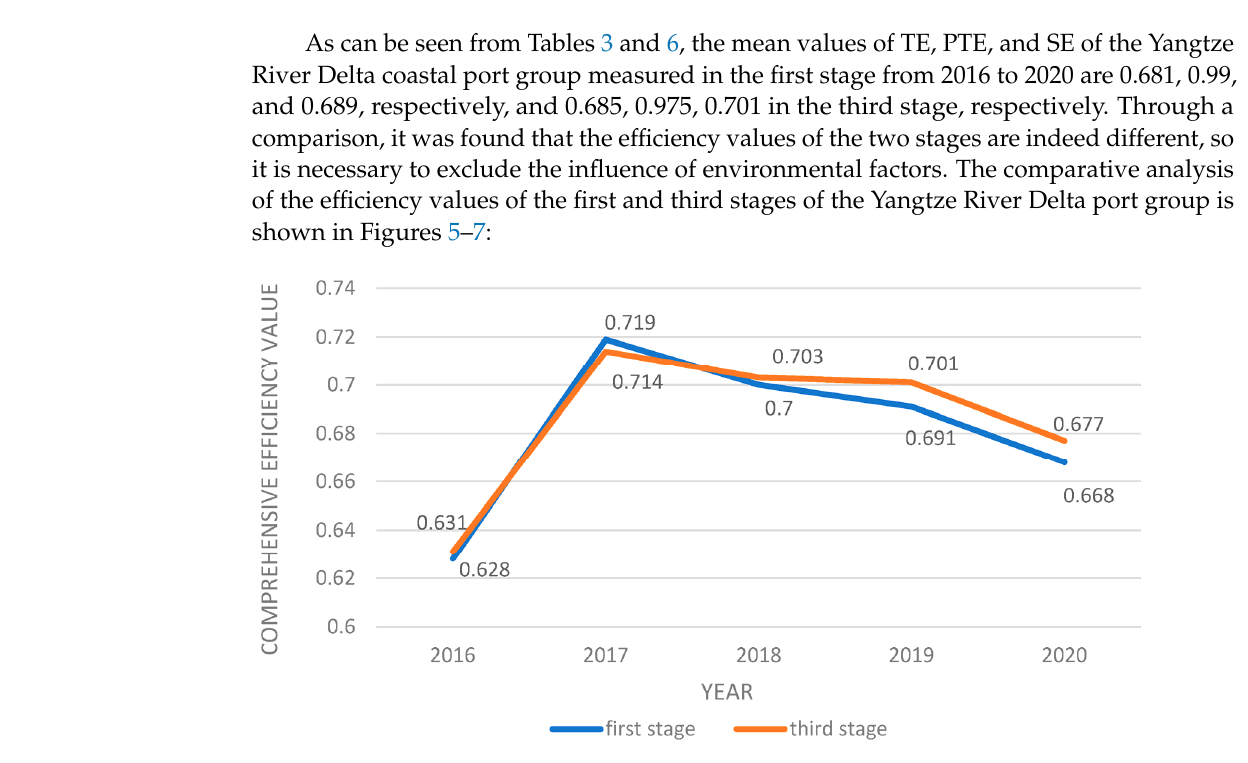
Figure 7. Comparison of the scale and efficiency of the Yangtze River Delta port group.